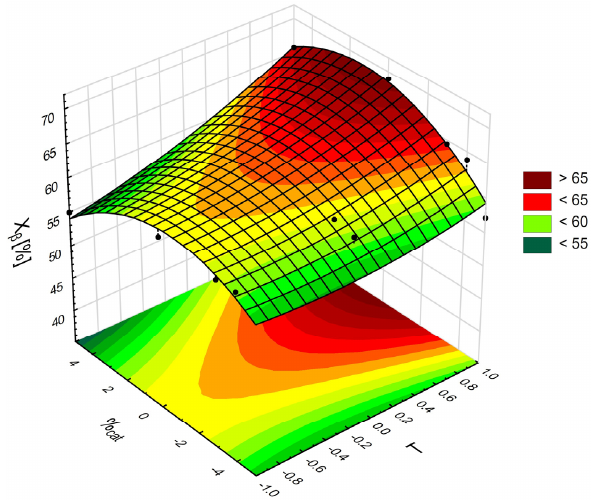
Figure 9. The of X β NMR variability depending on the reaction temperature (T) and the catalyst content (% cat ).